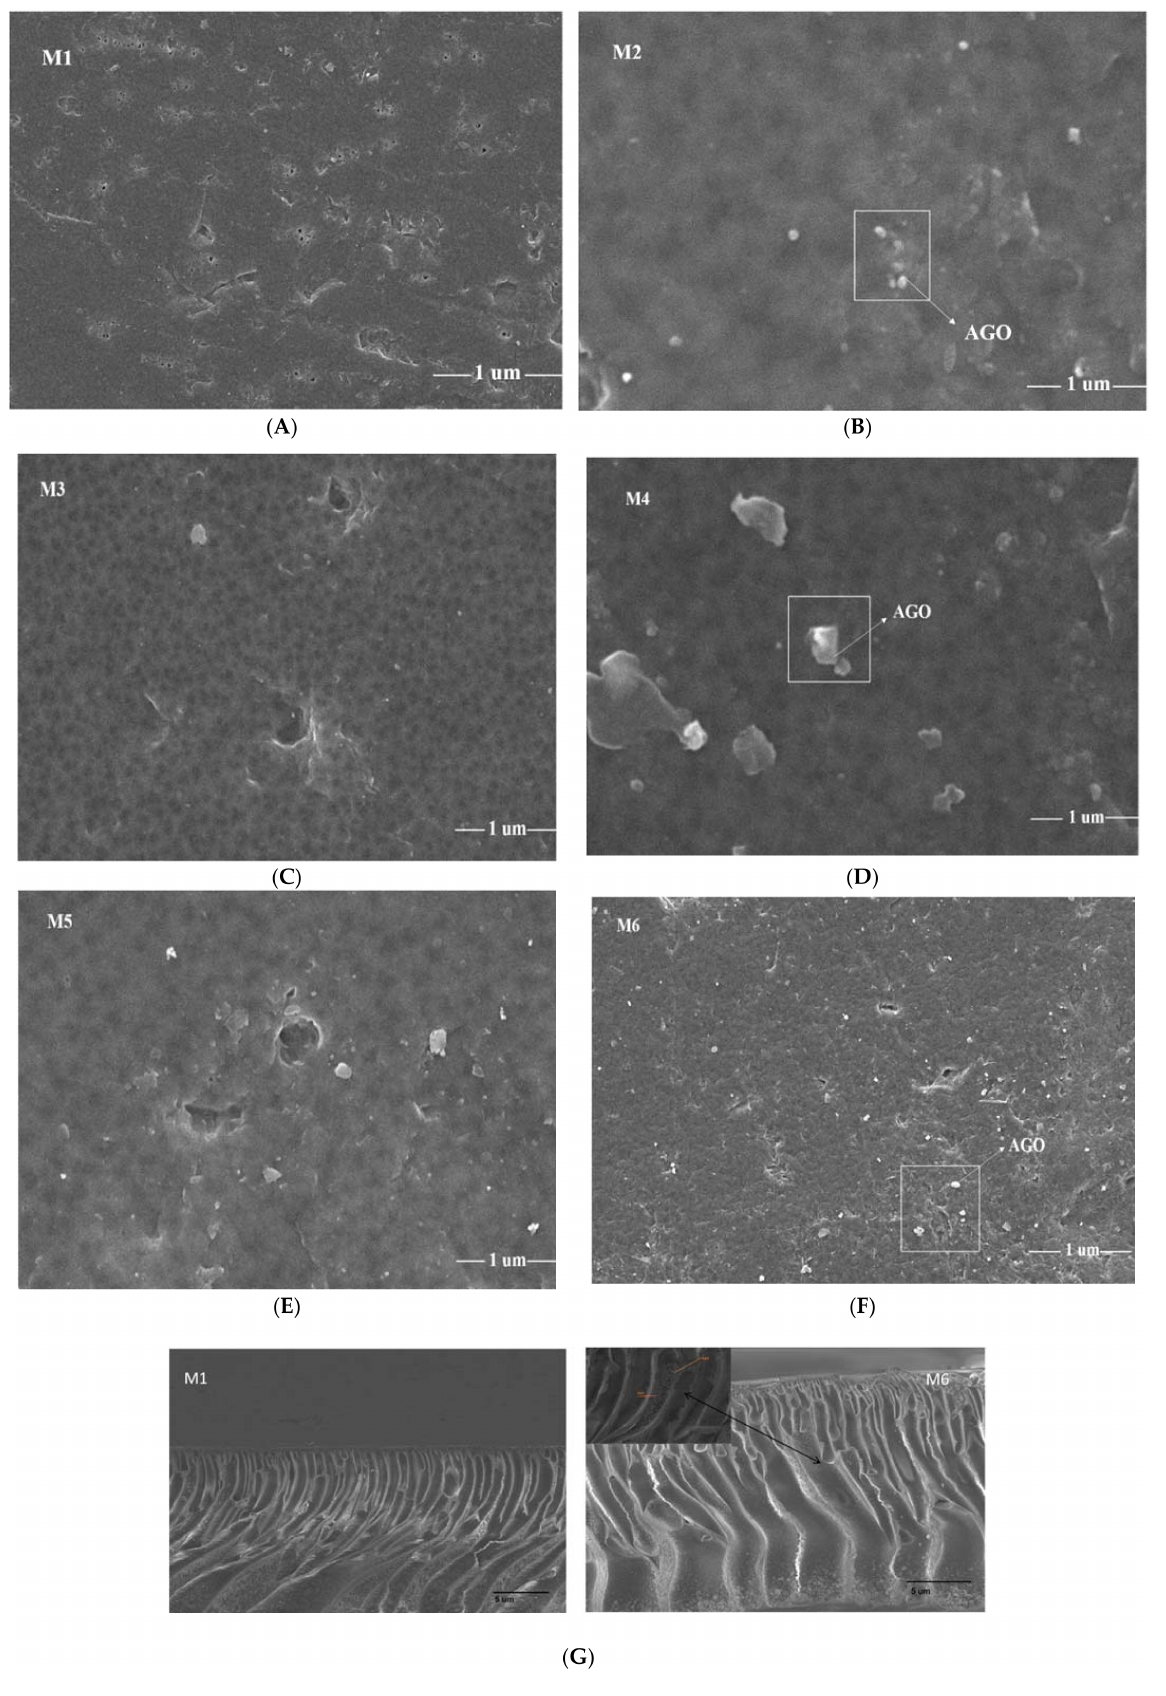
Figure 4. SEM images of M1 ( A ), M2 ( B ), M3 ( C ), M4 ( D ) M5, ( E ) and M6 ( F ) membranes. ( G ) Cross sectional SEM images of membranes M1(Pristine) and M6(1%